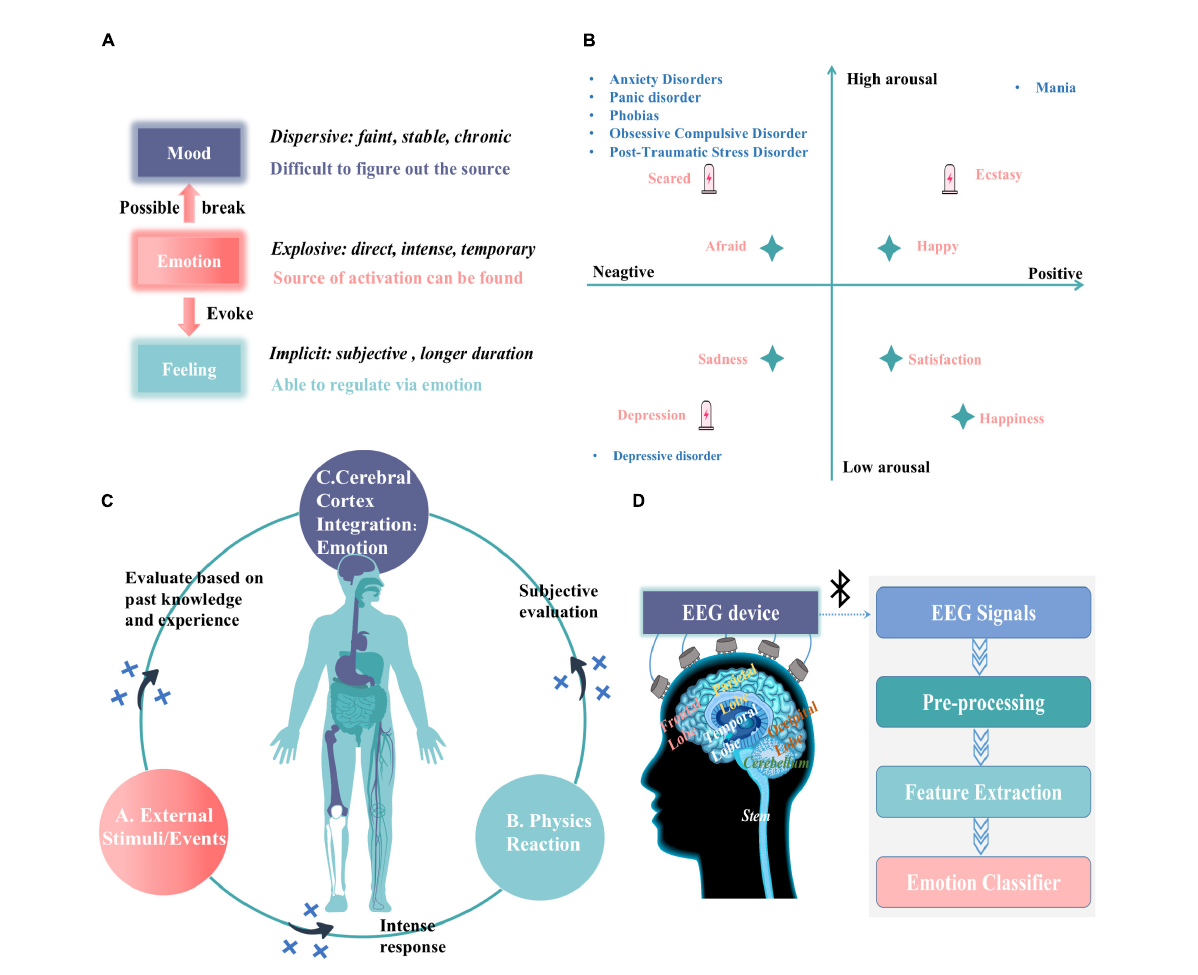
FIGURE1 Overview of the causes and methods of monitoring individual (subject) emotions. (A) Characteristics of mood, emotion, and feeling. (B) Expression of emotions space model and mental disorders. (C) The formation of emotion. (D) EEG emotion recognition